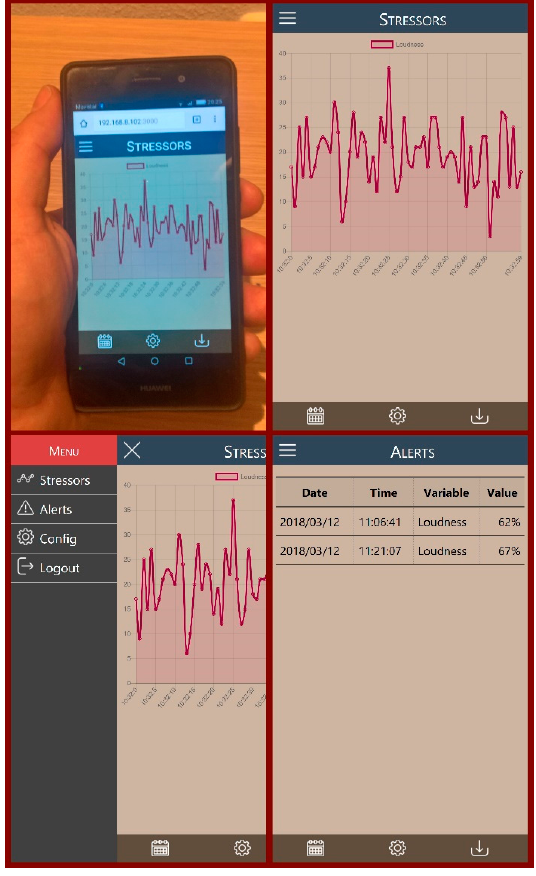
Figure 8. Web App prototype picture and screenshots.